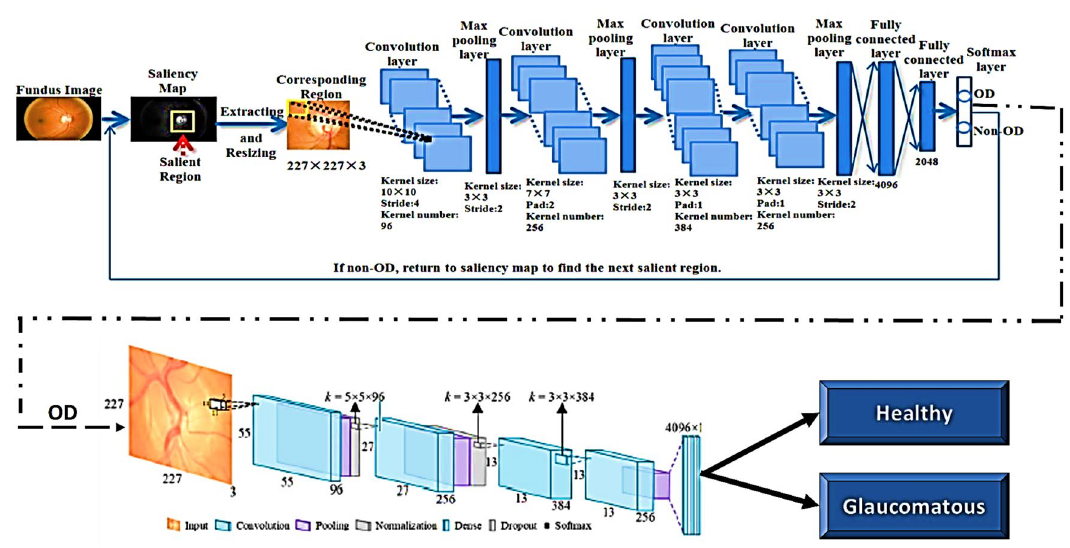
learning-based method VGGNet with hyperparameters settings. The performance of the proposed model is evaluated by using vari- ous performance